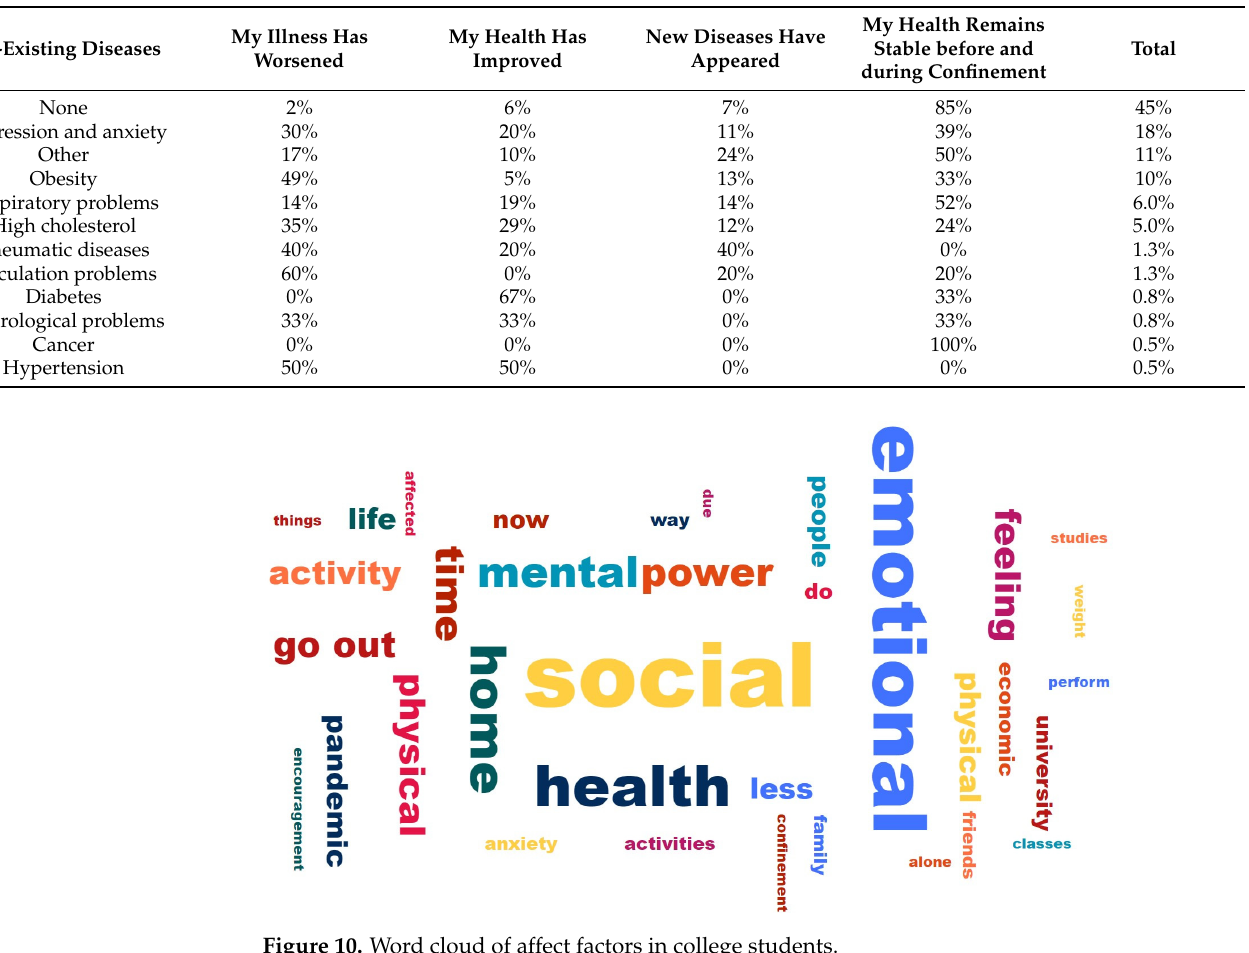
Figure 10 . Word cloud of affect factors in college